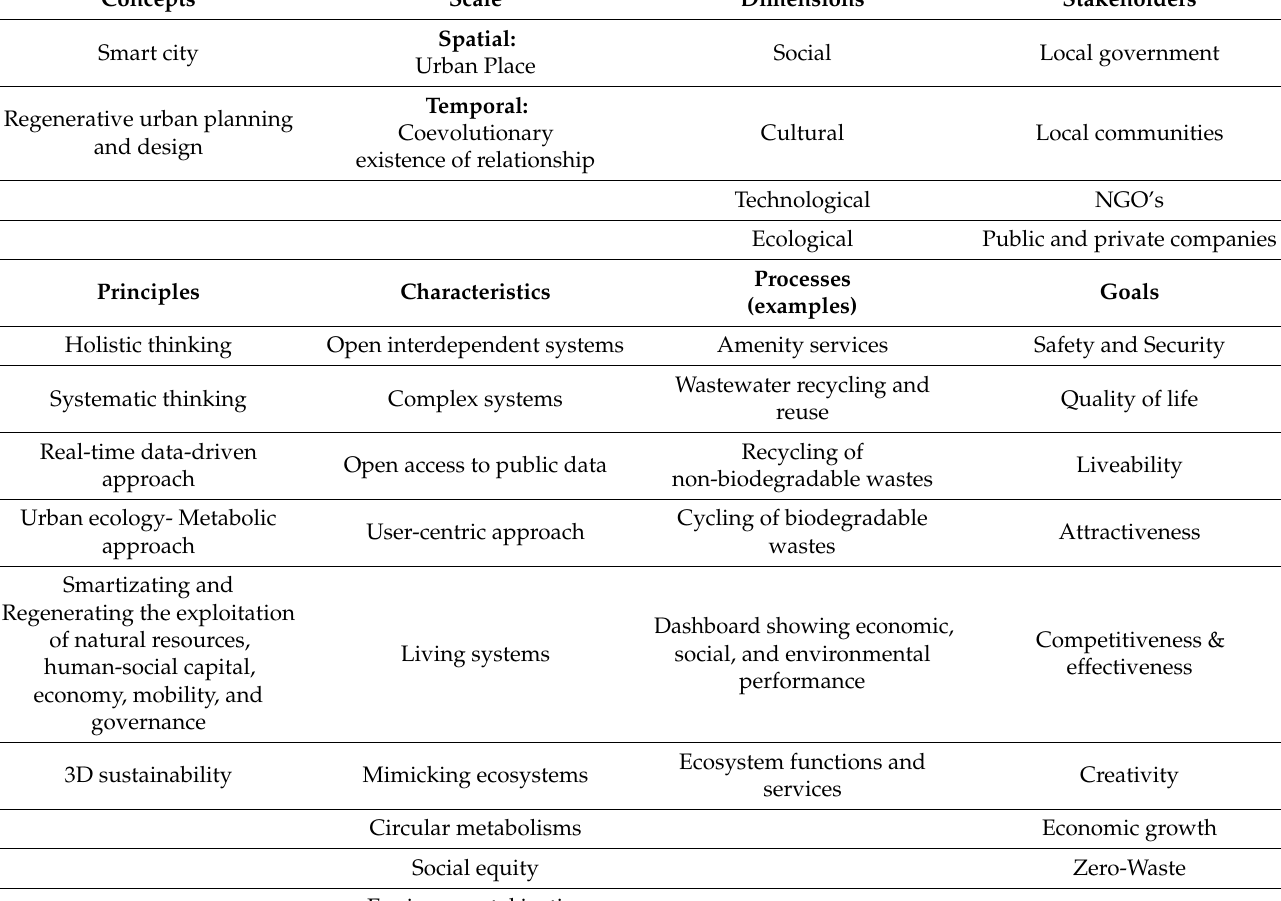
Table 1. An integrated conceptual framework for smart and regenerative urban places as complex systems (SRUP).